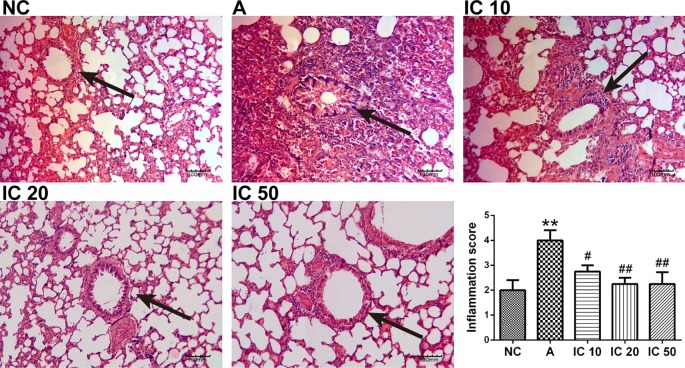
Icariin attenuated inflammation in the lung of asthmatic rats. The histological changes of the lung tissues in each group were investigated by H&E staining. The arrows indicated the changes of inflammation and mucus secretion in each group. Scale = 100 μm (magnification 200×). **p < 0.01 vs. NC group; #
p < 0.05 and ##
p < 0.01 vs. A group.